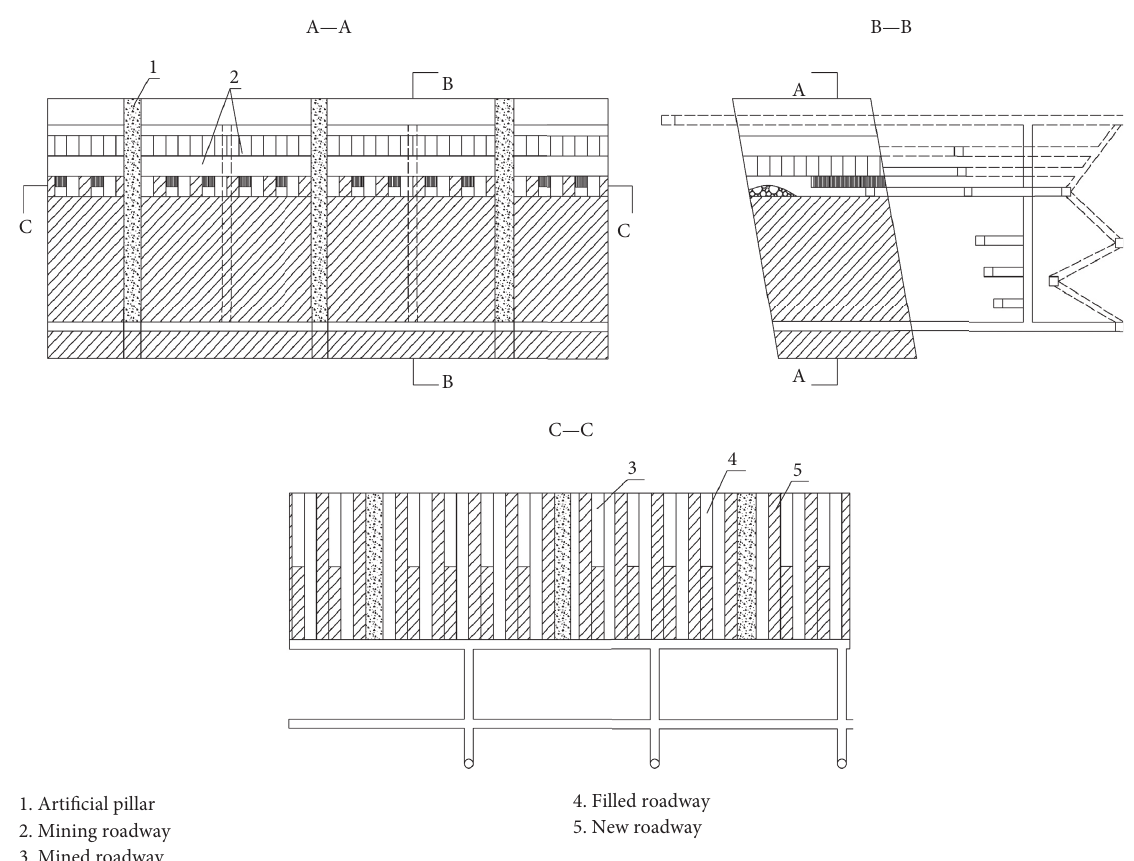
Figure 4: Scheme of partitioned unloading panel downward segmented filling